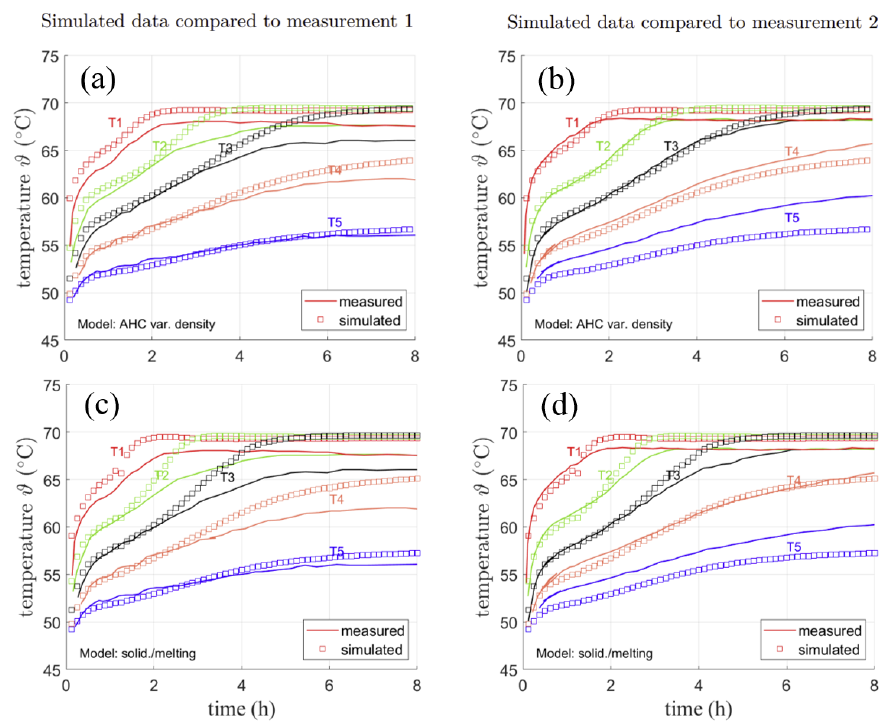
Figure 11. Measured and simulated temperatures for two repeated simulations conducted in [4] for AHC with variable density ( a , b ) and SM ( c , d